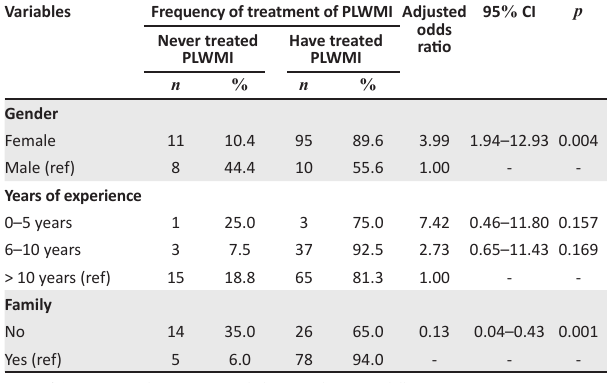
TABLE 2: The influence of frequency of treatment of people living with a mental illness on selected participant characteristics by using a binary logistic regression